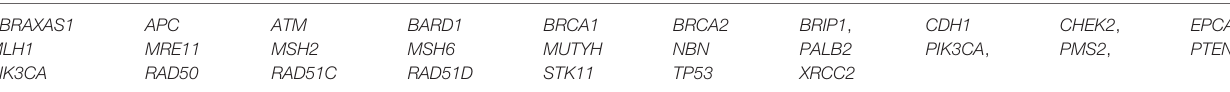
TABLE 4 | Panel of 26 genes used for NGS analysis through SOPHiA Hereditary Cancer Solution (HCS). ABRAXAS1